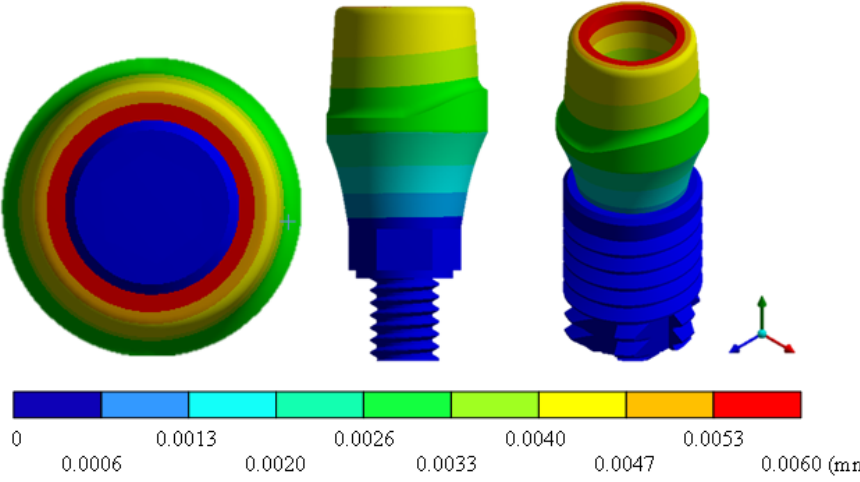
Figure 15. Total general displacement for On1 Esthethic-type implant (Ti 6 Al 4 V) .